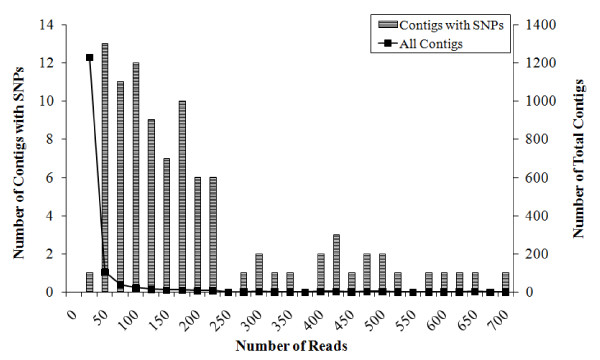
Contig totals versus number of reads per contig amongst those contigs with identified SNPs (bars) and all contigs (squares).